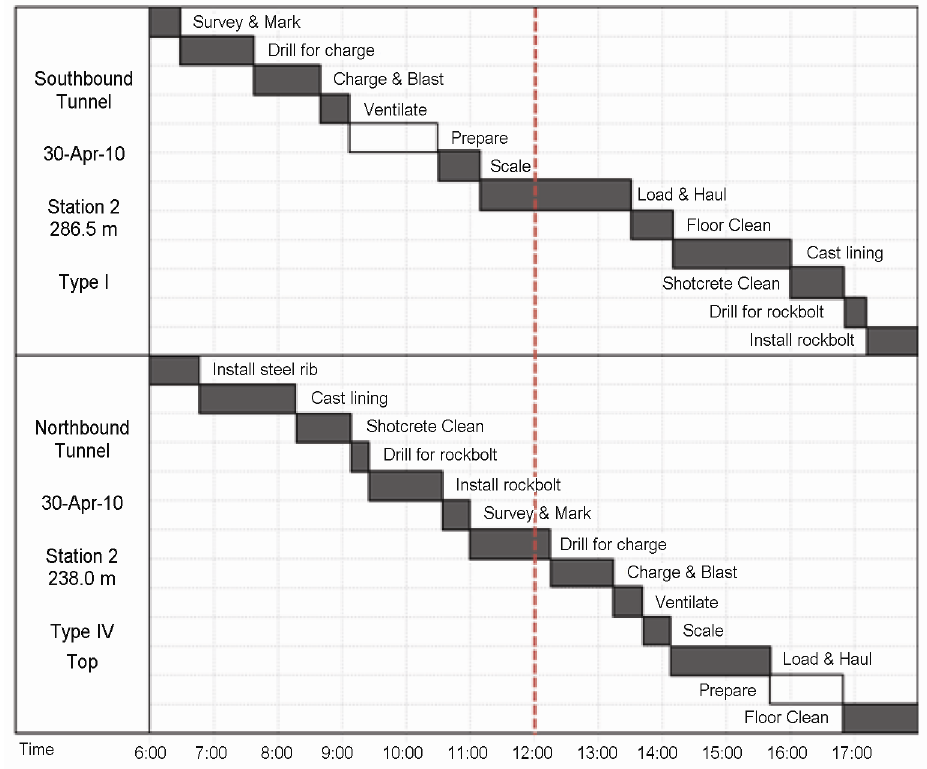
Fig. 4. An example of an operation-level schedule for concurrent Type-I and Type-IV-top